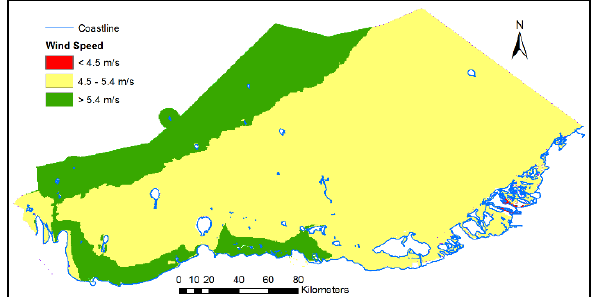
Figure 7: Reclassified annual wind speed